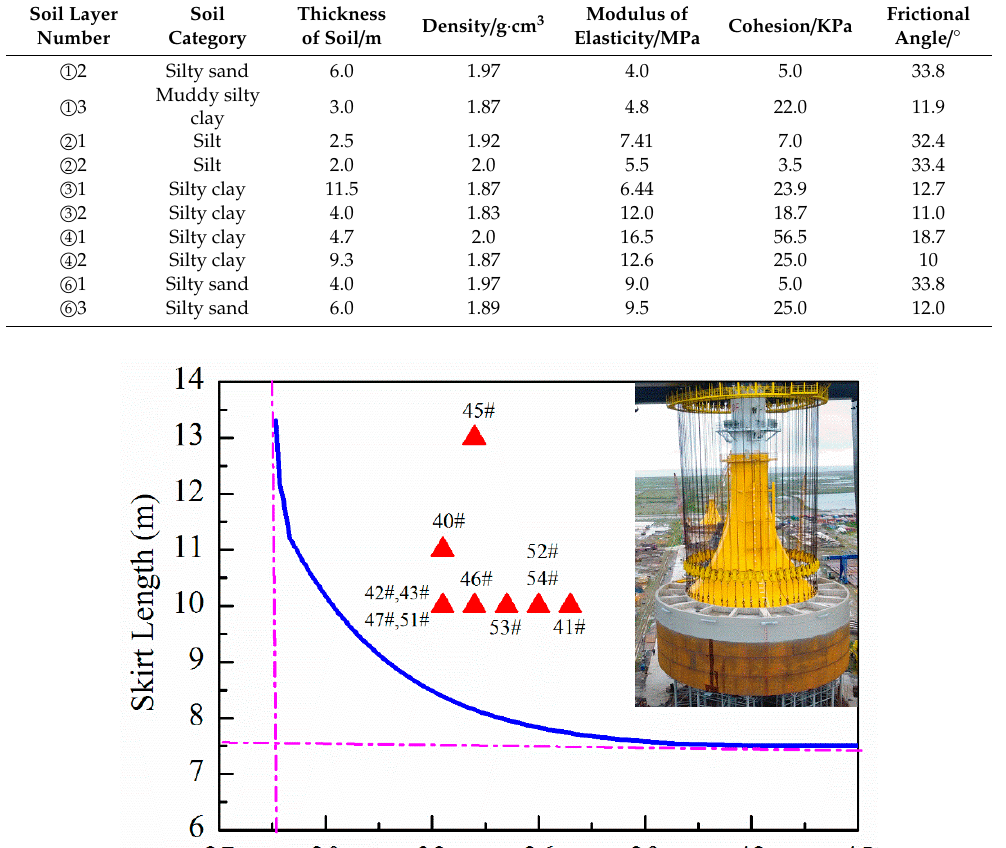
Table 2. The characteristic parameters of the soil layer.